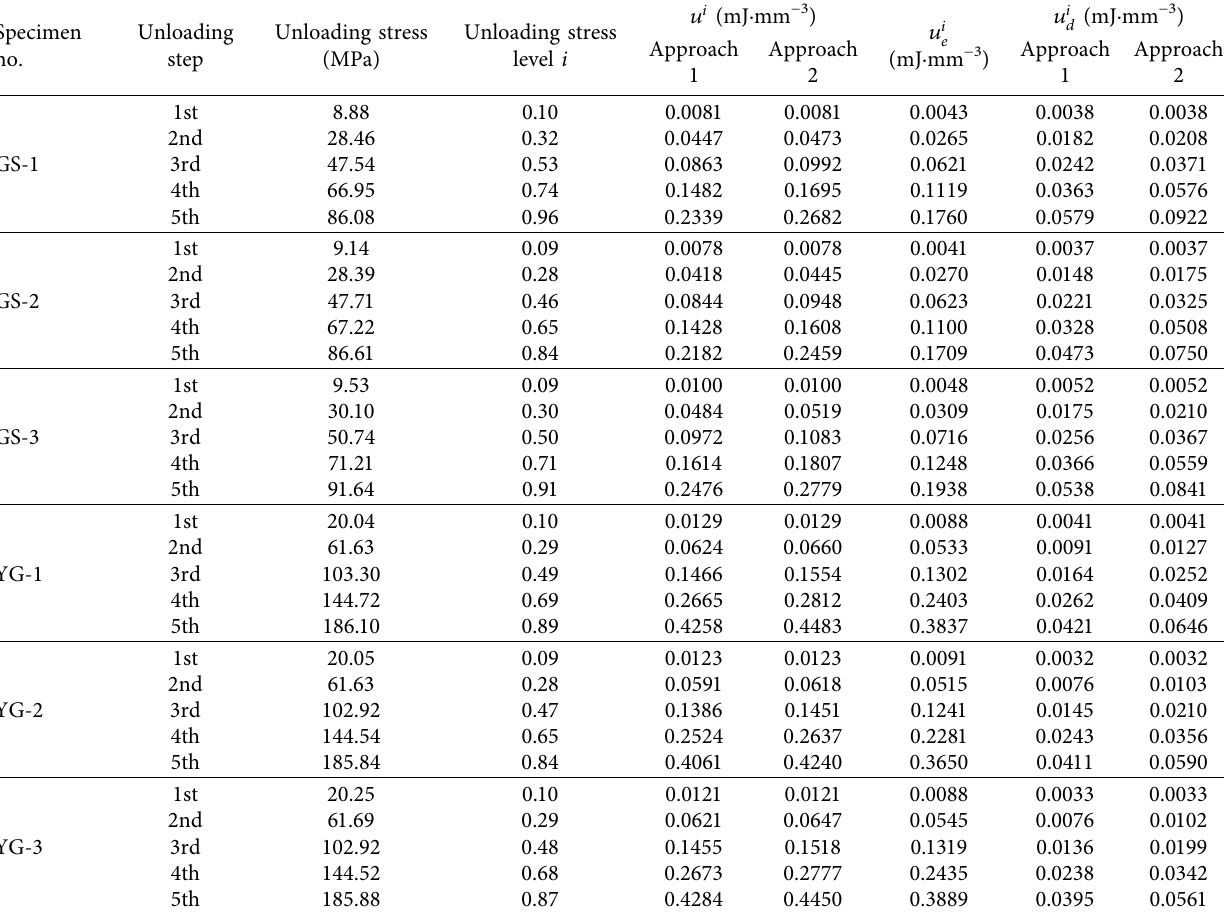
Table 2: Testing parameters at the unloading